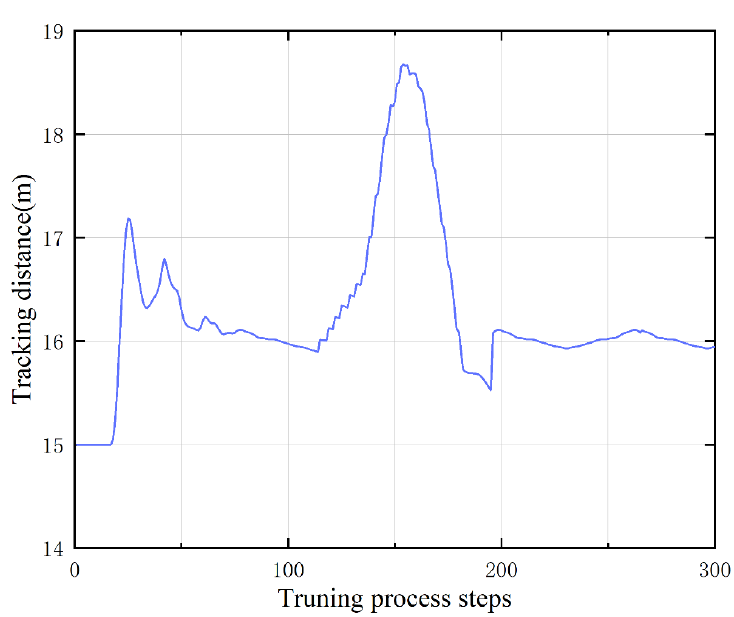
Figure 9. Tracking distance between the ego and target.